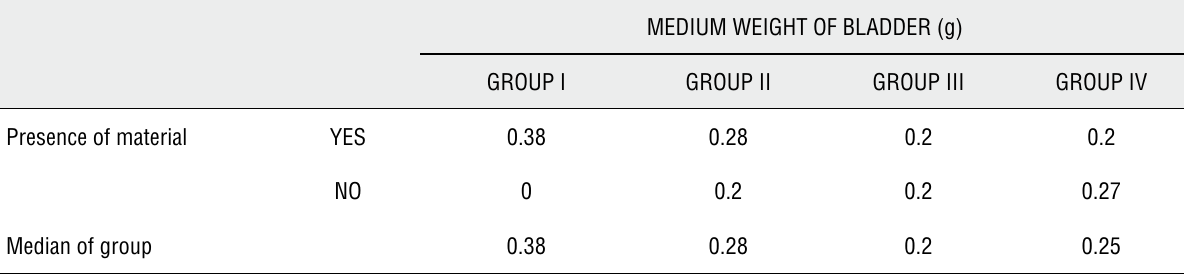
Table 1 - comparison of bladder weight and the presence of the material at the moment of euthanasia in the 4 studied groups.